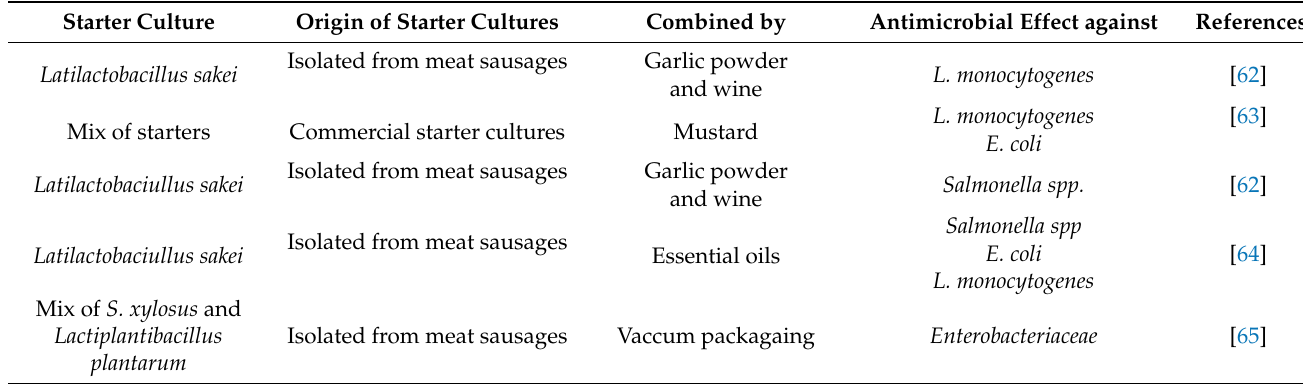
Table 2. Combination of starter cultures and other hurdle technology to improve antimicrobial effect against foodborne pathogens in meat products’